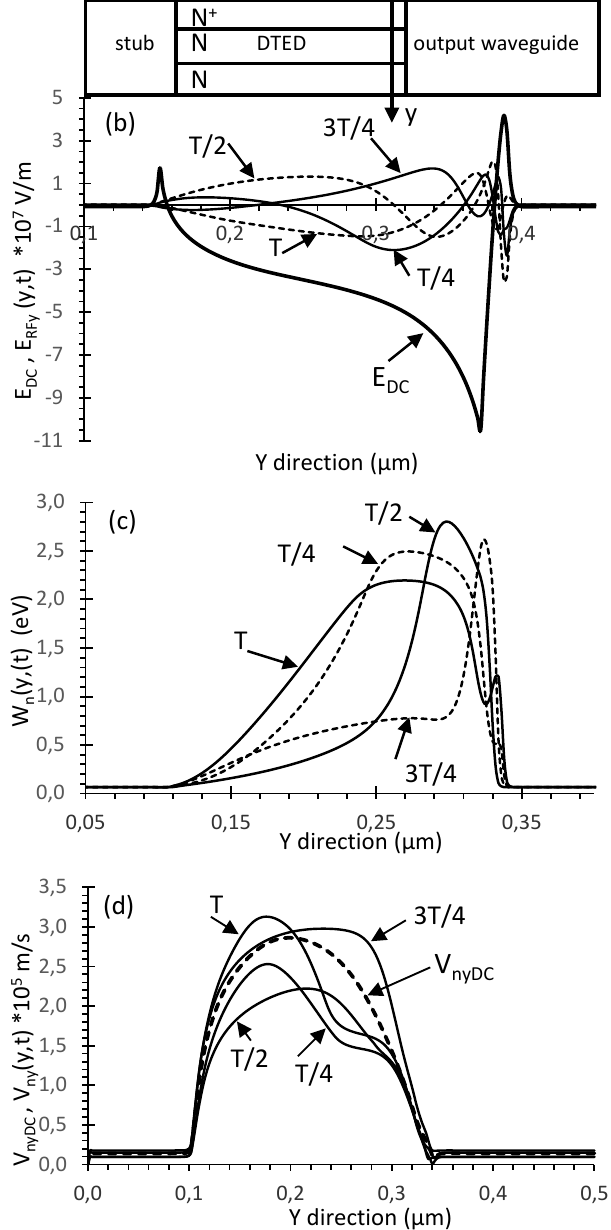
Figure 5: Y direction space-time evolutions of the transverse electron transport quantities over a RF cycle at x=130